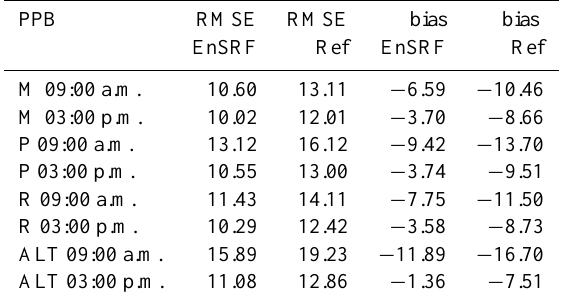
Table 4. Monthly averaged statistics RMSE and bias (in ppb) when comparing a run with assimilation (EnSRF) and a reference one (Ref) against the measurements provided by the ground stations, differentiated for each type of station (as indicated by Table 3) at 09:00 a.m. and 03:00 p.m.